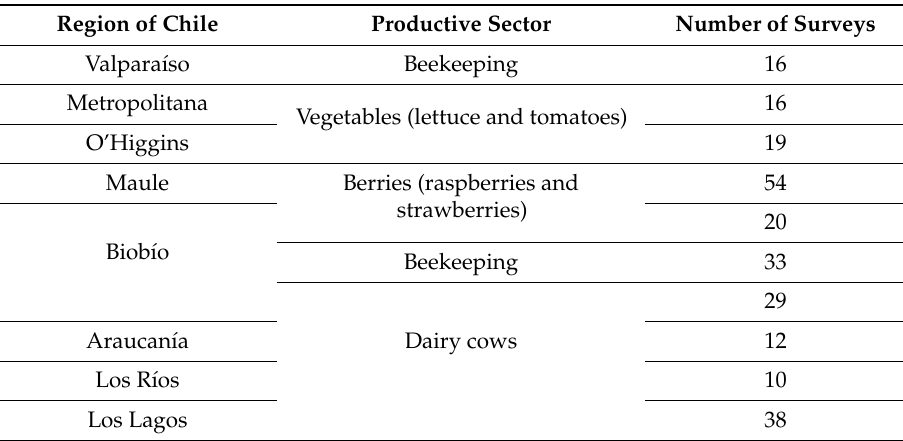
Table 1. Surveys undertaken by region and productive